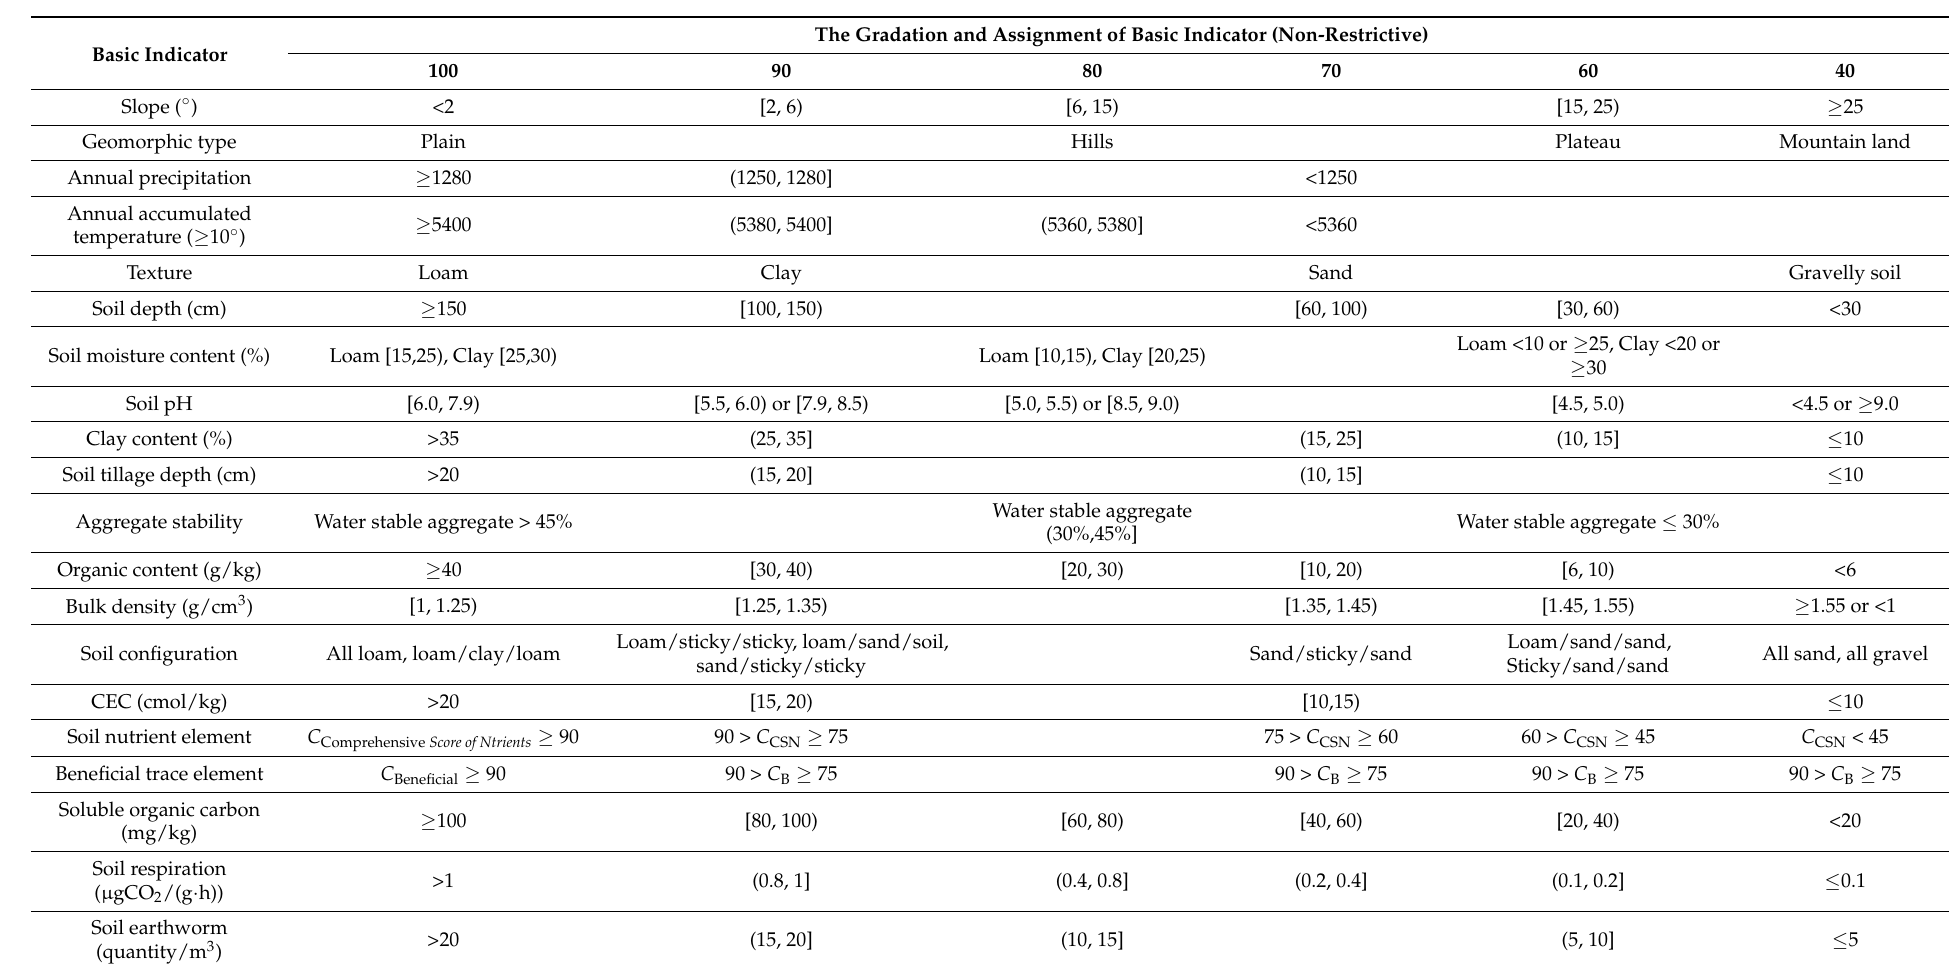
Table 2. Grading reference for basic indicators of SH